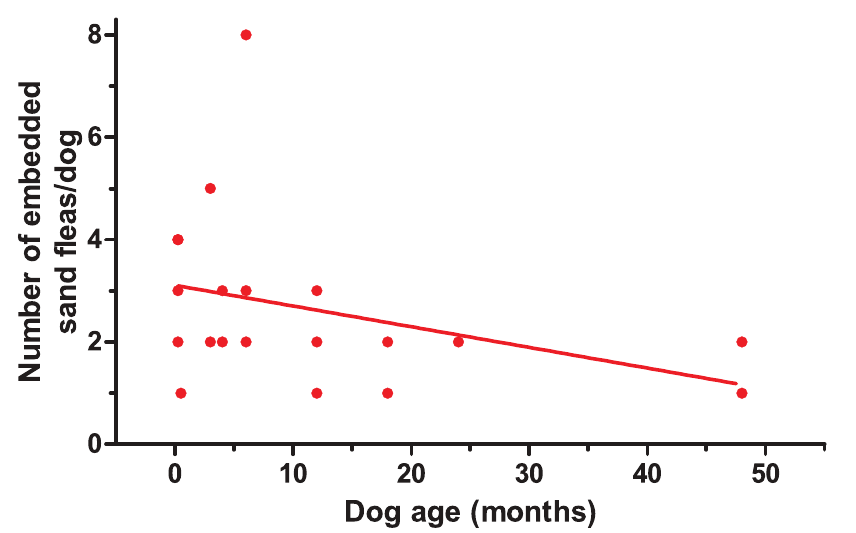
Fig 5. Correlation between age of dogs infected with T . penetrans and the number of embedded sand fleas (rho = -0.47, p = 0.039).